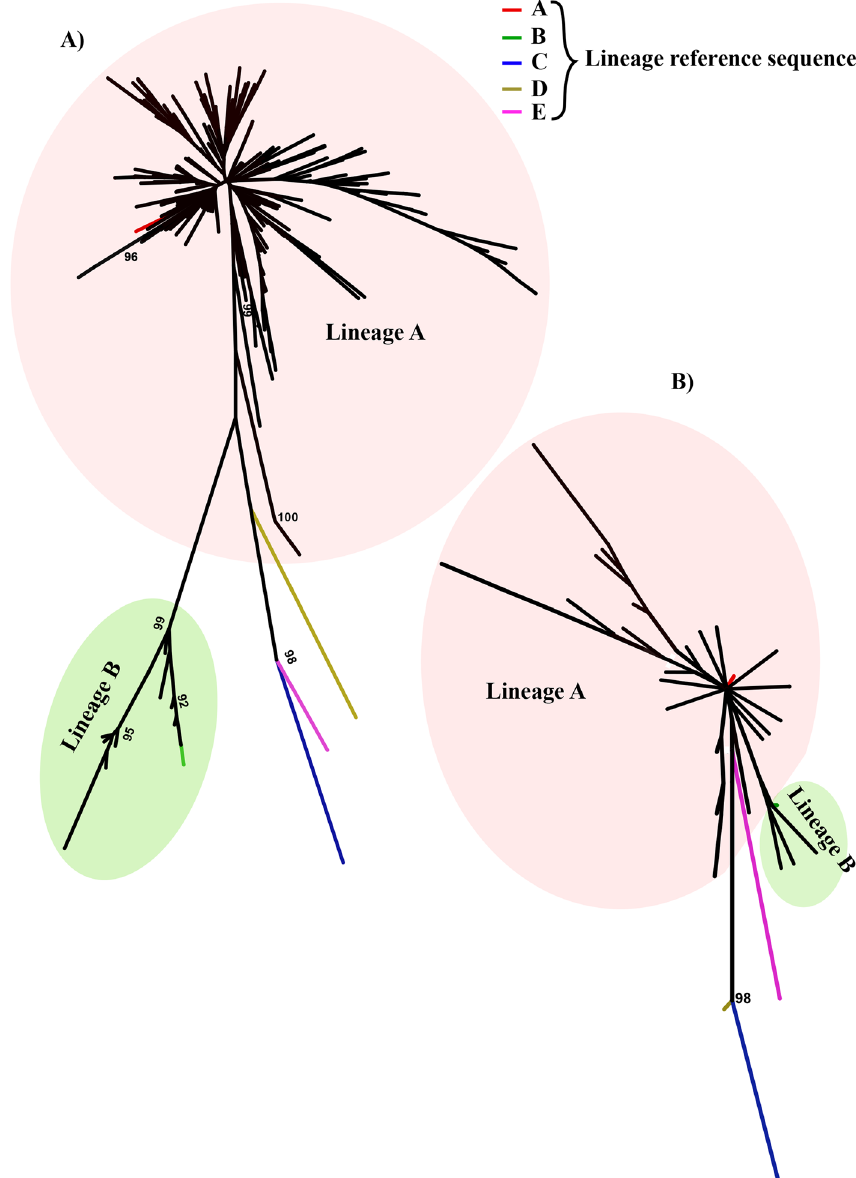
Figure 3. Neighbour-joining phylogenetic tree of south Indian domestic sheep. The NJ tree was based on 359 and 352 sequences for ( A ) D-loop (950 bp) and ( B ) CYTB gene (856 bp), respectively. The NJ tree was constructed using the software MEGA (version 7) 14 and the final output was edited in Inkscape 1.0 (https:// inksc ape.